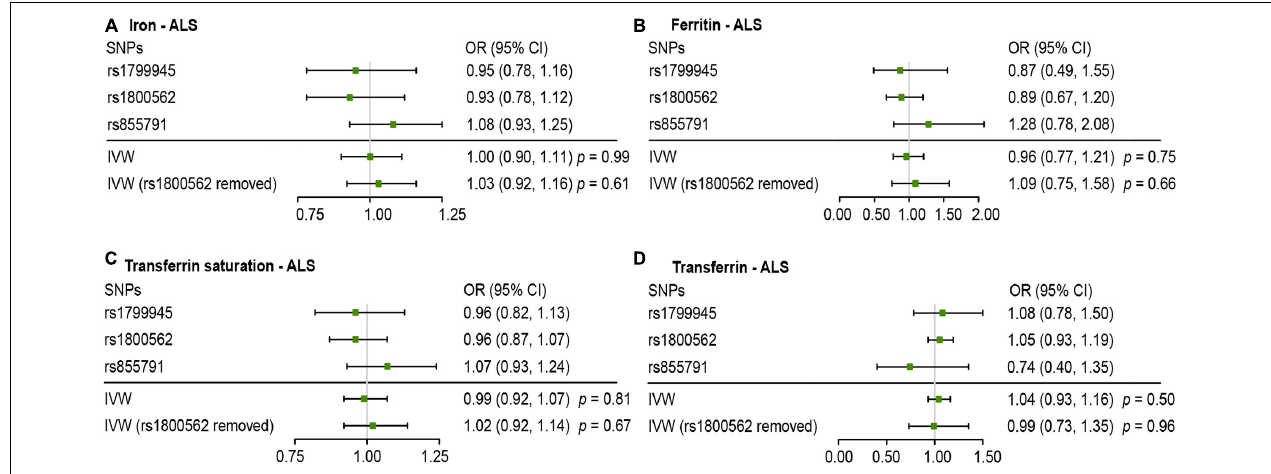
FIGURE 2 | Mendelian randomization (MR) estimates for each of the four biomarkers of iron status in conservative analyses. Panels (A–D) respectively indicate the causal estimates of iron, ferritin, transferrin saturation and transferrin on amyotrophic lateral sclerosis (ALS). SNPs, single nucleotide polymorphisms; OR, odds ratio; CI, confidence interval; IVW, inverse variance